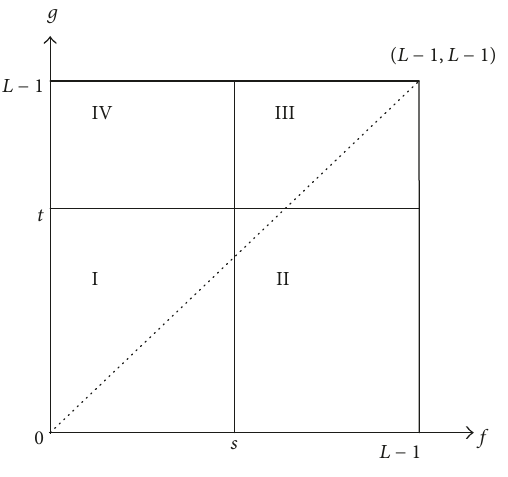
Figure 2: Two-dimensional projection